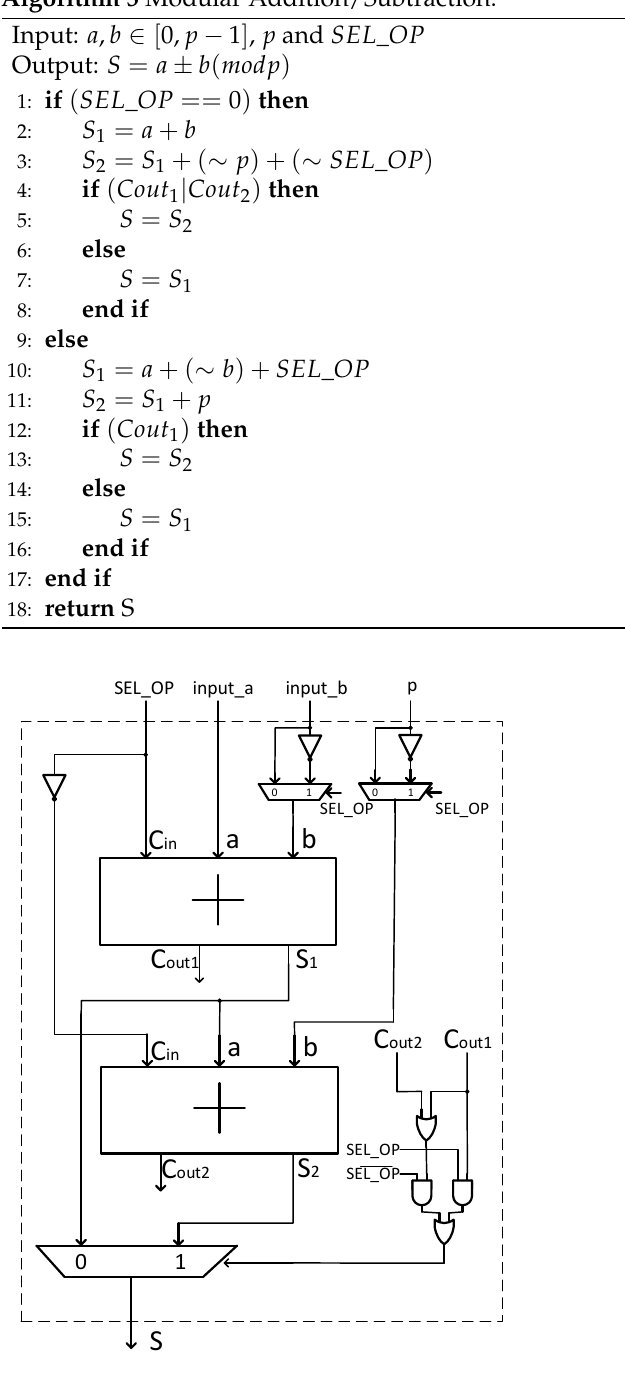
Figure 2. Modular Addition and Subtraction